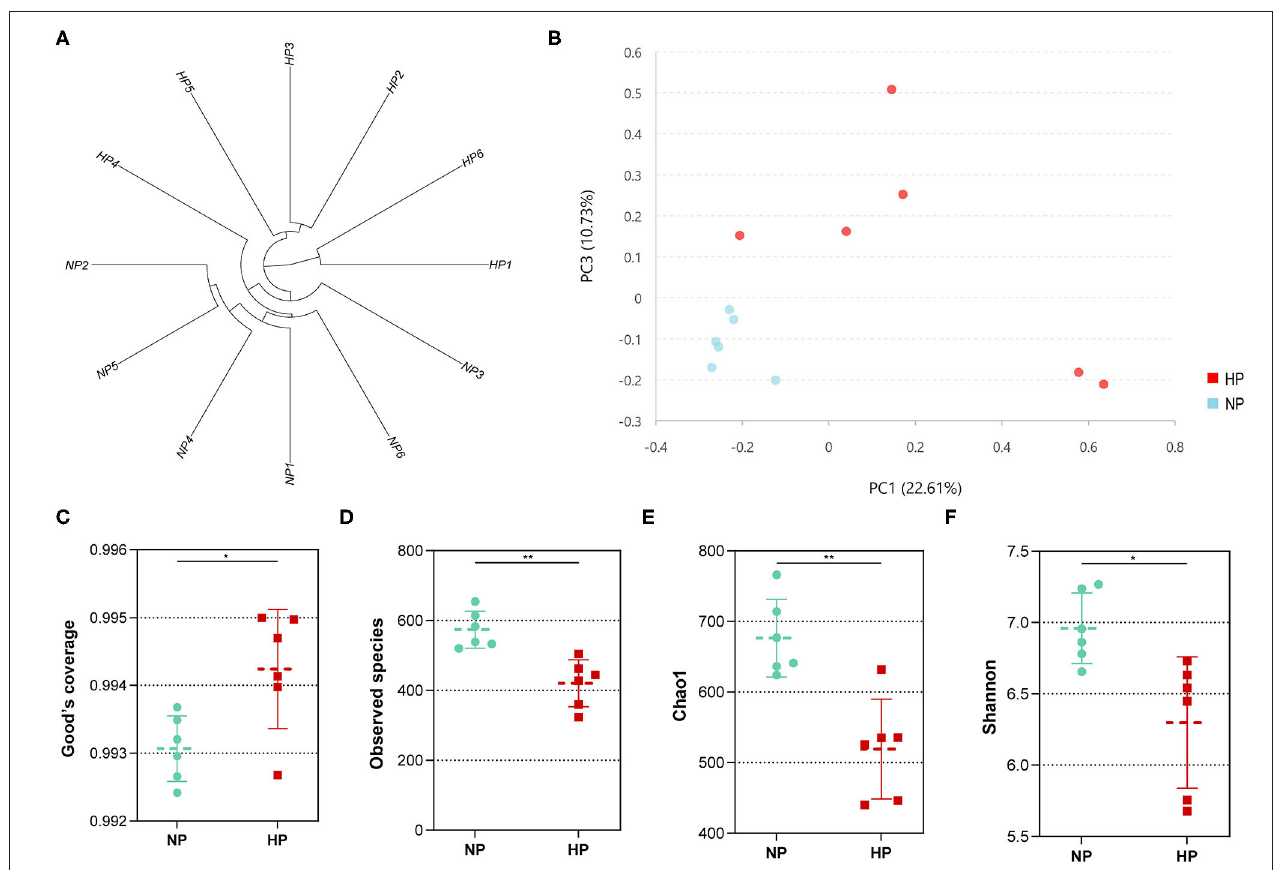
FIGURE 3 | (A) Hierarchical clustering analysis of hindgut bacterial community (NP1–NP6 and HP1–HP6 are cecal samples of goats fed with NP and HP diets, separately). (B) PCA of cecal digestal microbiota. (C–F) Alpha diversity of microbiota of goats fed with NP and HP diets. *0.01 < p < 0.05; ** p < 0.01.